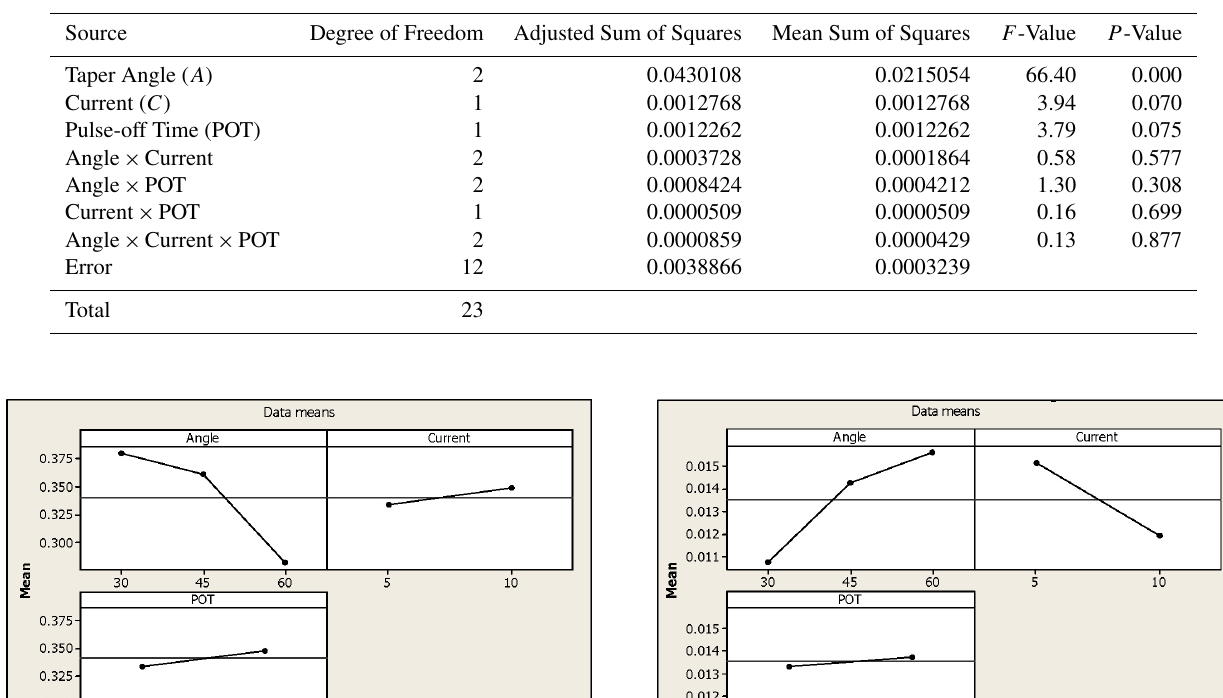
Figure 5. Effect of controllable factors over the kerf width along the length of workpiece. Table 4. Analysis of variance for the kerf width.